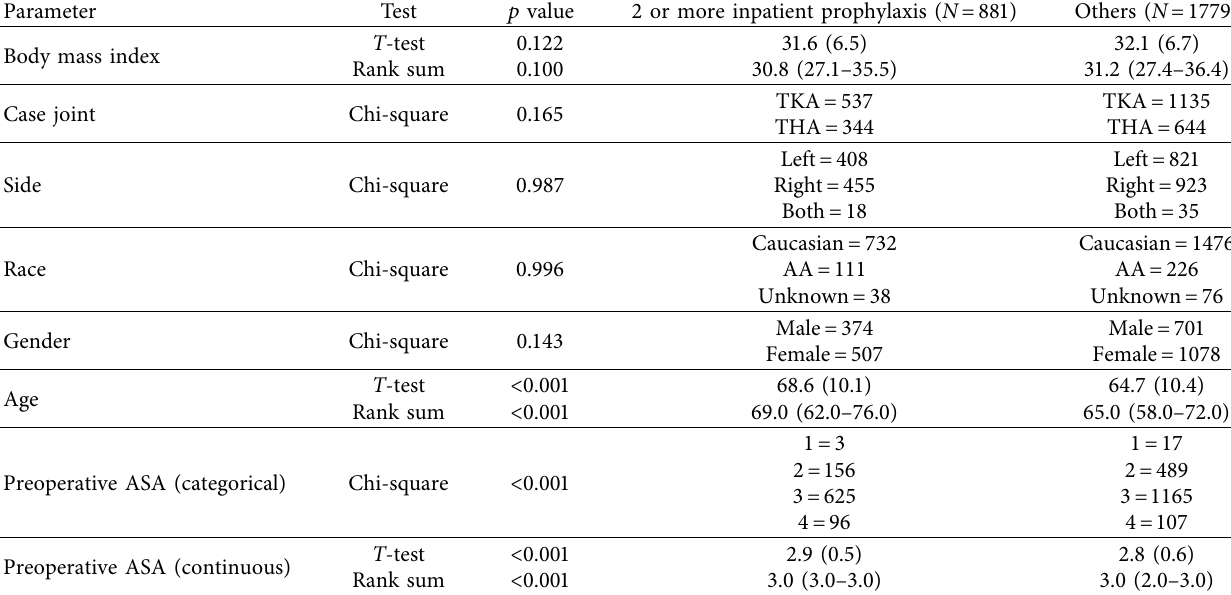
Table 2: Demographics of patients on 2 or more VTE medications postoperatively.